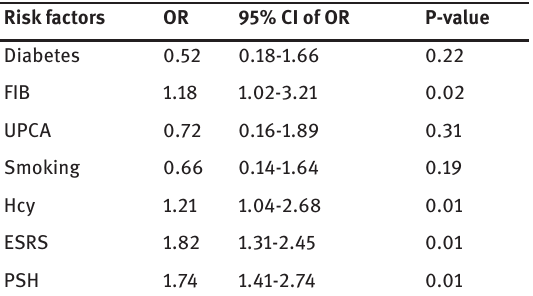
serum Hcy, Figure 3a . For ESRS, the prediction sensitivity, specificity and AUC were 69.99%, 64.52% and 0.74 (95%CI:0.63-0.84) respectively, Figure 3b .